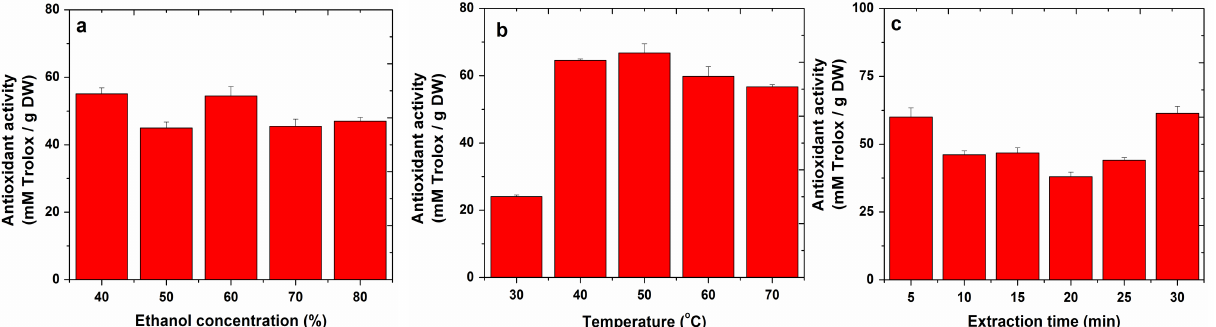
Figure 4. DPPH radical scavenging activity of apple extracts obtained by sonication in different conditions: ethanol concentration ( a ), temperature ( b ) and extraction time ( c